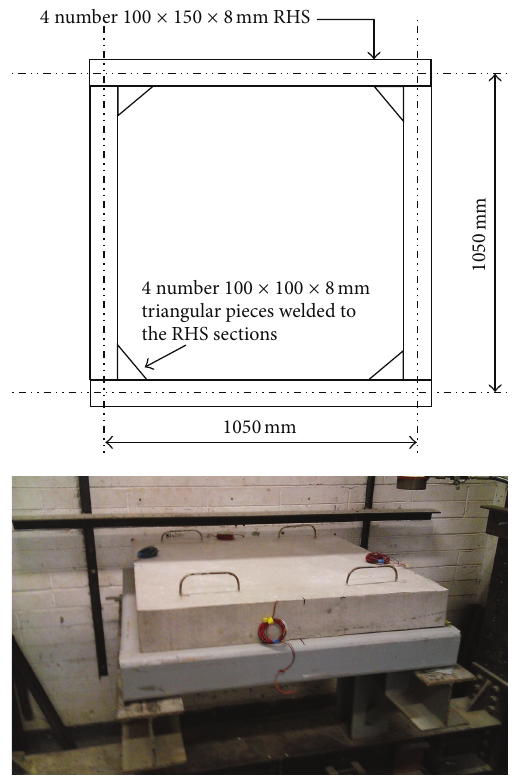
Figure 3: RHS frame used to support the concrete